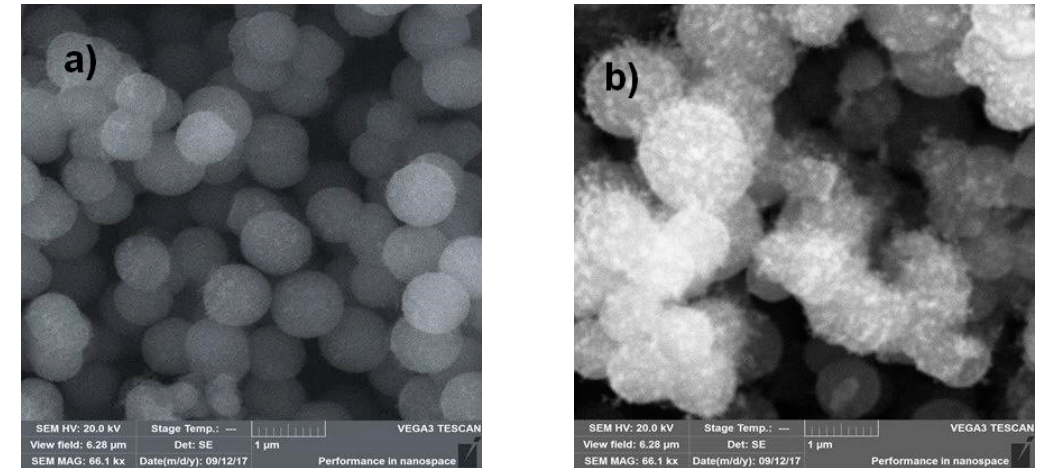
/ SiO 2 -C 3 H 6 -(30%)NH 2